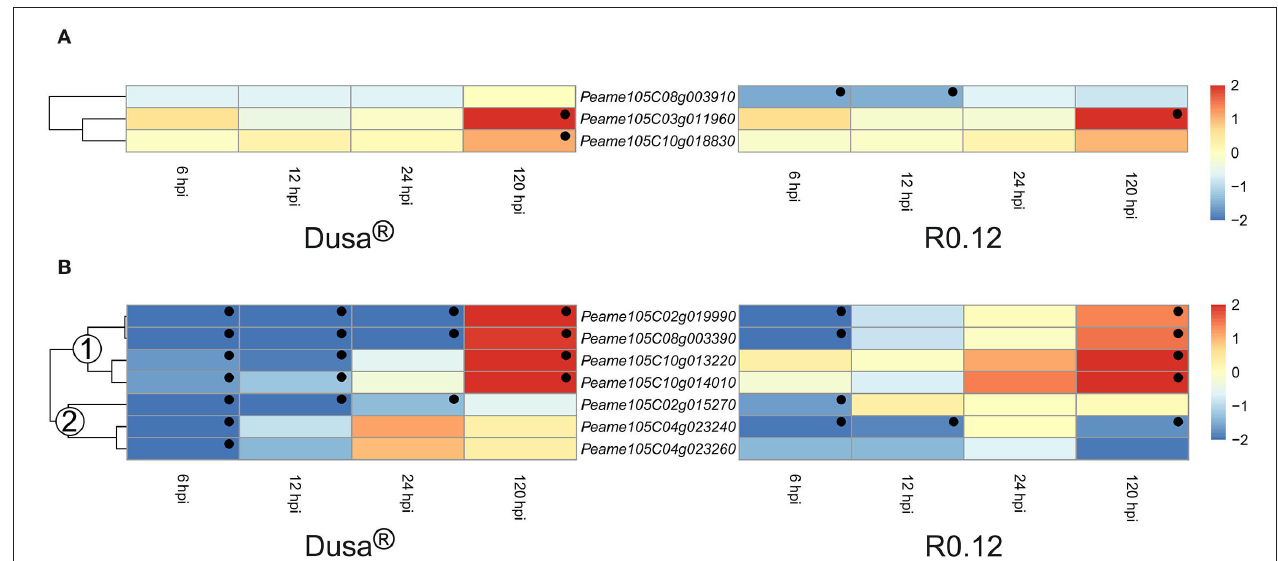
FIGURE 9 | Heatmap and dendrogram illustrating the expression of genes encoding for apoplastic cysteine proteases and metalloproteases in Persea americana following inoculation with Phytophthora cinnamomi. Differentially expressed genes (DEGs) encoding for (A) apoplastic cysteine proteases and (B) apoplastic metalloproteases from both partially resistant (Dusa ® ) and susceptible (R0.12) P. americana rootstocks are indicated. Differential expression at 6, 12, 24, and 120h post inoculation (hpi), following inoculation with P. cinnamomi , was calculated using mock-inoculated (dH 2 O) sample libraries as the control. Significantly upregulated [log 2 (fold change) > 1, p = 0.05] genes are indicated by a red color, while significantly downregulated [log 2 (fold change) < − 1, p = 0.05] genes are indicated in blue, the intensity of which represents scale. Significant DEGs are indicated with a black dot. The expression of metalloprotease coding genes was broadly clustered into two groups based on the dendrogram from Dusa ® and were indicated numerically on the dendrogram. Only cysteine proteases and metalloproteases that were differentially expressed in one or more samples and were predicted to localize to the cell membrane or extracellular space are shown.